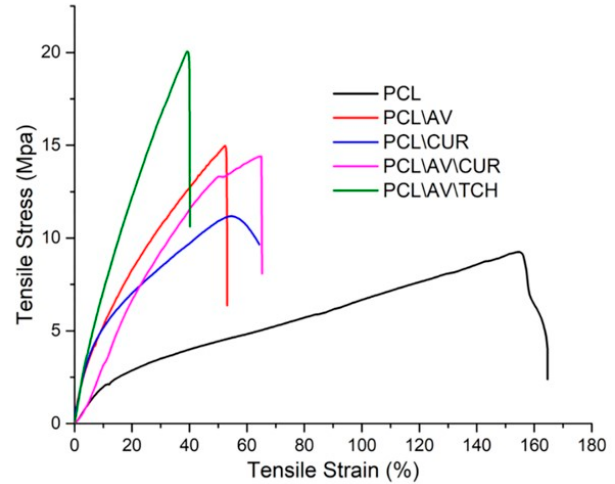
Figure 3. Tensile properties of PCL, PCL / AV, PCL / CUR, PCL / AV / CUR and PCL / AV / TCH nanofibrous